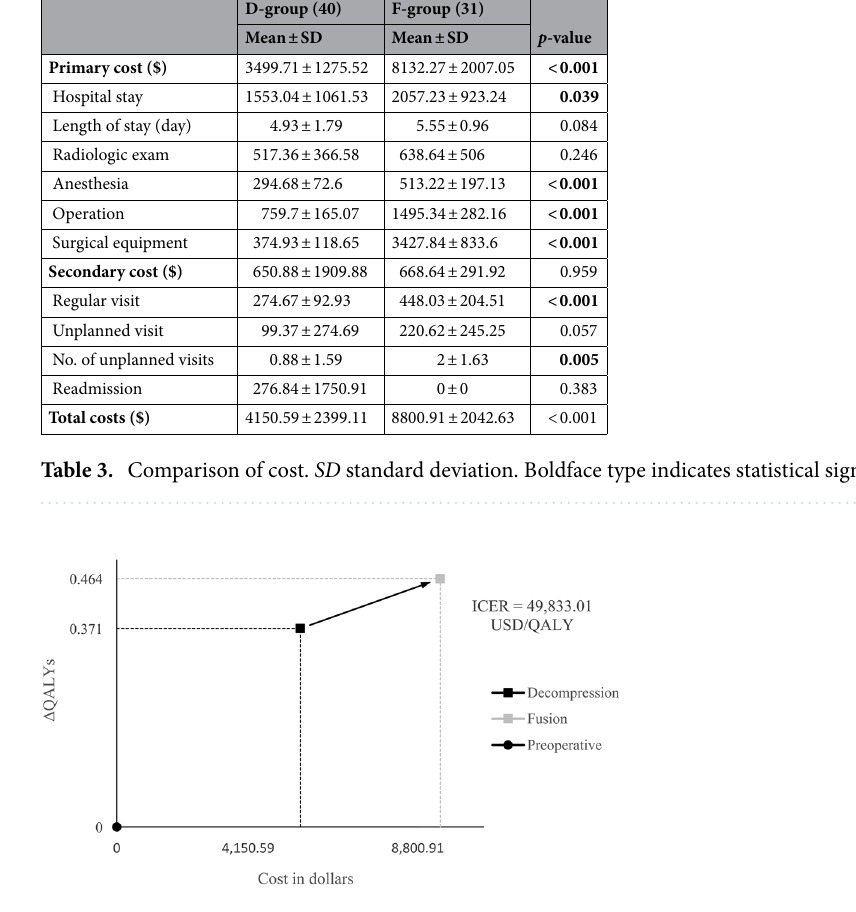
Figure 4. Cost-utility of decompression versus fusion. The costs and QALYs gained by decompression or fusion over a 2-year time